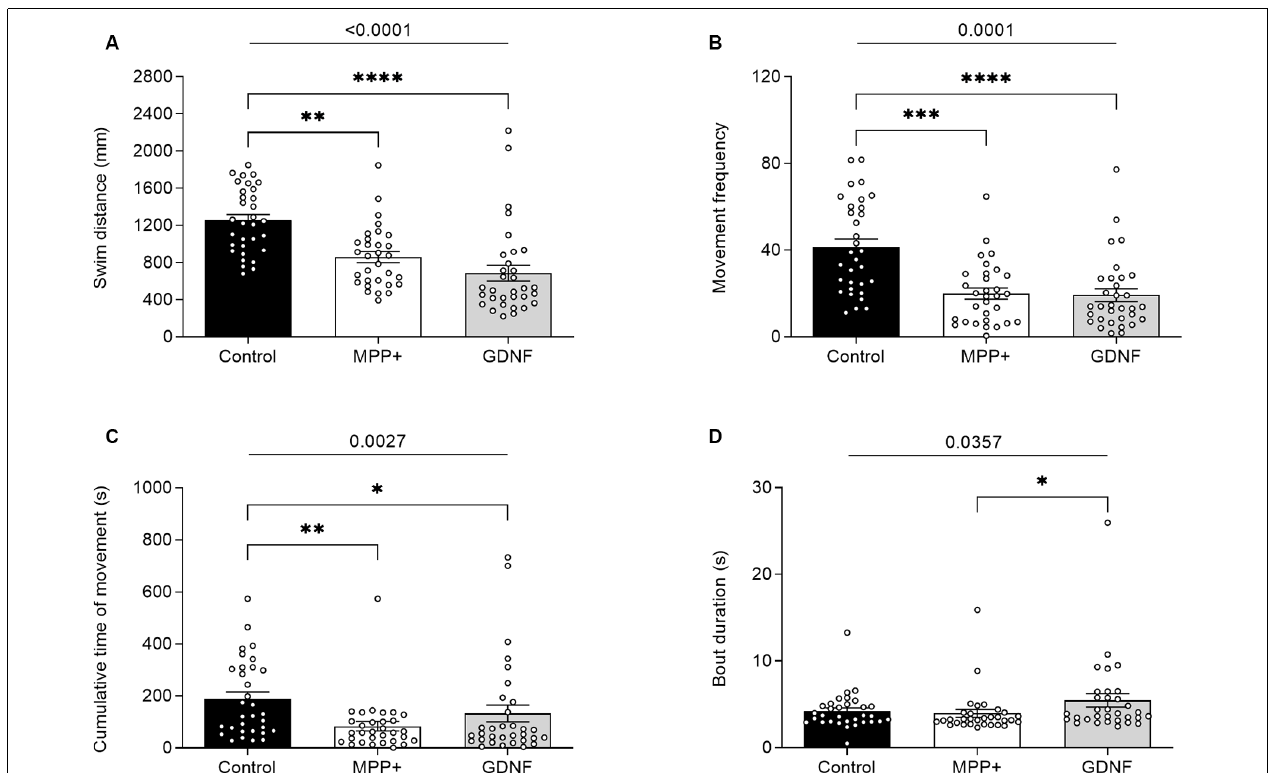
FIGURE 5 | Effects of glial-derived neurotrophic factor (GDNF) on motor activity of MPP+-treated zebrafish larvae. Larvae were incubated in the absence (black bars) or presence (white and gray bars) of 500 µ M MPP+ and injected with 72.9 ng GDNF (gray bars) at 4 dpf before assessing motor activity at 6 dpf for (A) distance swum (mm); (B) frequency of movement; (C) cumulative time of movement (s) and (D) swim bout duration during five consecutive light-on phases. Data are represented as means ± SEM from a single experiment, control group n = 32, MPP+ group n = 31, GDNF group n = 32. Normality was tested using D’Agostino and Pearson omnibus normality test followed by the two-tailed Kruskal–Wallis test ( p -value shown above graph) and Dunn’s post hoc analysis. ∗∗∗∗ p < 0.0001, ∗∗∗ p < 0.001, ∗∗ p < 0.01, ∗ p < 0.05, for multiple